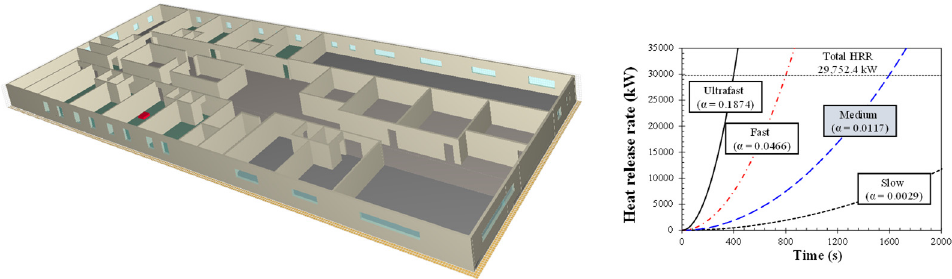
Figure 2. Simulation model for fire.